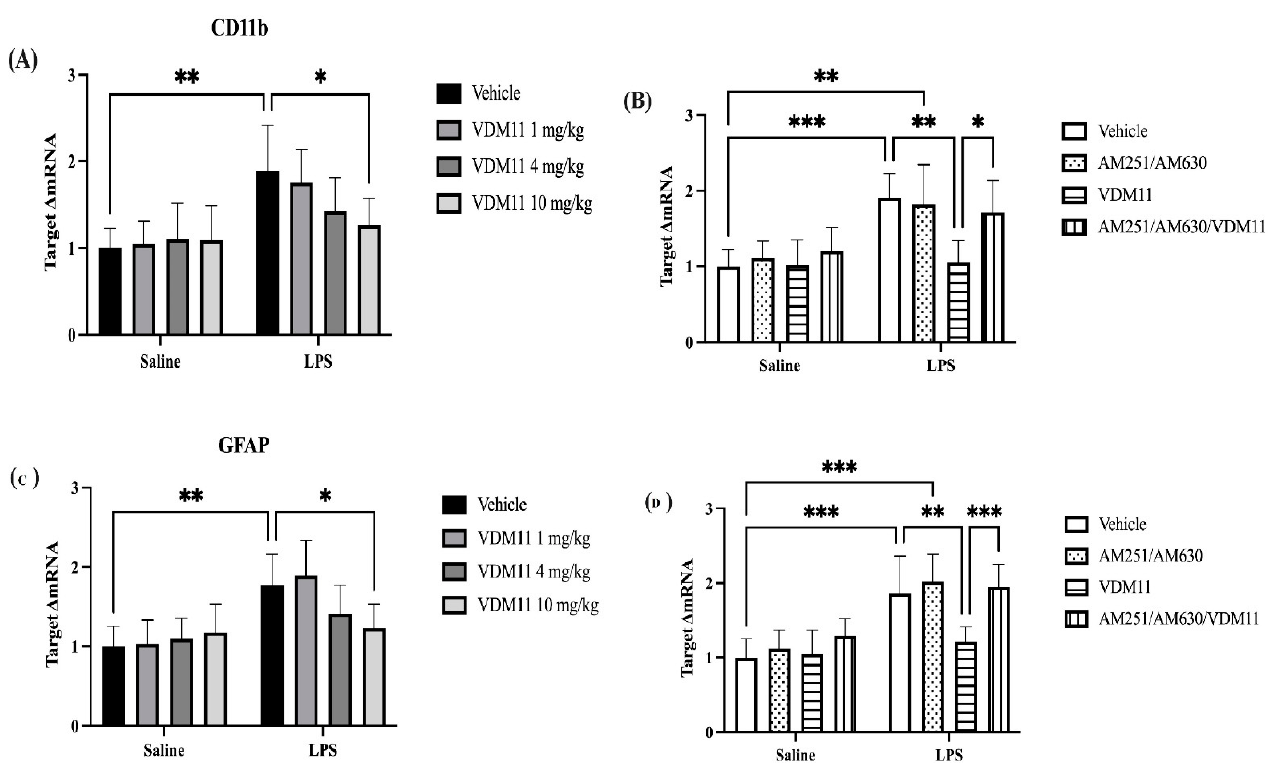
Figure 10. ( A , C ) anandamide reuptake inhibitor VDM11, 10 mg/kg, substantially reduced the LPS-induced elevation of CD11b and GFAP in the hippocampus. ( B , D ) Combining treatment with 1 mg/kg each of AM251 (a CB1 receptor antagonist) and AM630 (a CB2 receptor antagonist) mitigated the effects of 10 mg/kg of VDM11 on the elevation of CD11b and GFAP brought on by LPS injection in the hippocampus. * p < 0.05; ** p < 0.01; *** p < 0.001.